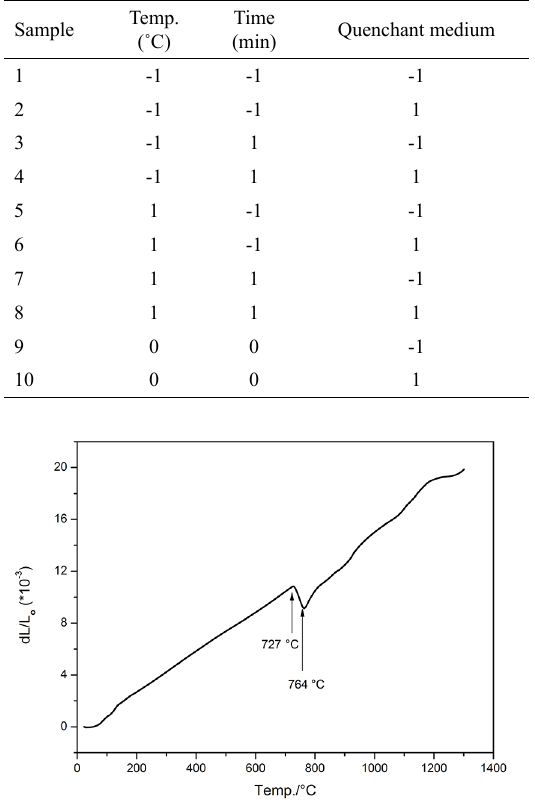
Figure 2. Dilatogram obtained after heating with a rate of 10 °C / min up to 1300 °C of AISI 4340 steel. Table 4. Results of hardness and percentage of distortion for heat -treated samples. Mean Sample Hardness